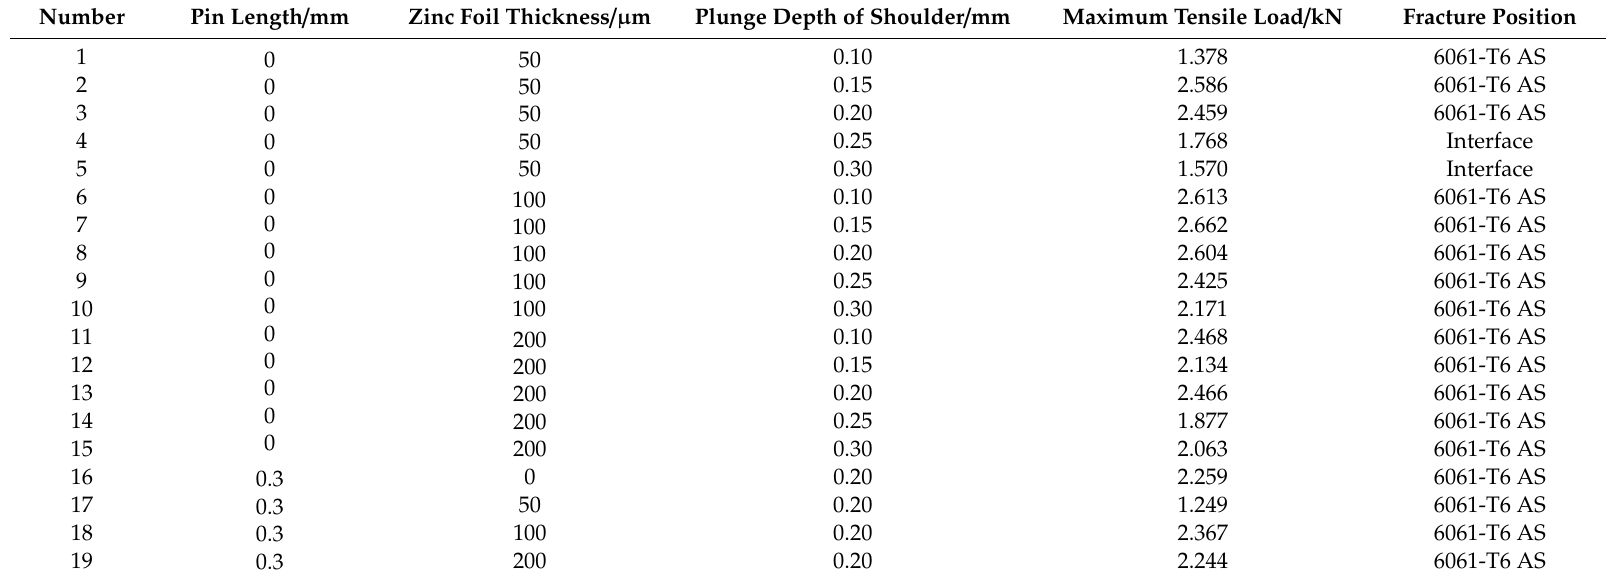
Table 3. Experimental parameters and tensile strength of No. 1–No.